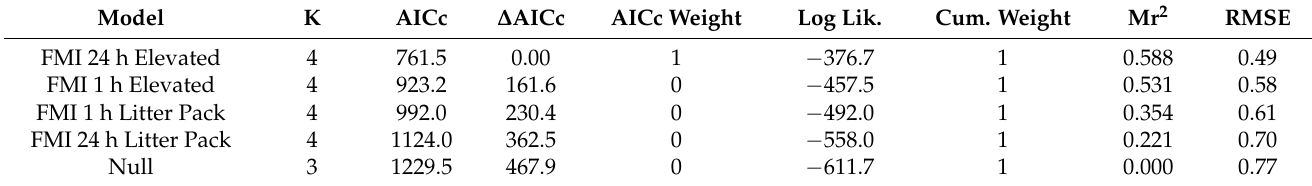
Figure 6. Plots of percentage of litter fine fuel moisture content, percentage of gravimetric fuel moisture stick fuel moisture content, and 24 h Fuel Moisture Index (FMI). ( a ) Percentage of gravimetric fuel moisture stick (c. 10 h fuels) moisture content (% FMC) plotted against percentage of gravimetric litter (c. 1 h fuels) fine fuel moisture content (FFMC %). ( b ) Highest-ranking linear mixed model that relates 24 h 0.75 m elevated FMI against log gravimetric litter fine fuel moisture content (FFMC %). Forest types are indicated by coloured dots, where red = dry forests and green = wet forests. Table 1. Akaike information criterion (AIC) statistics for linear mixed models, with site as a random effect for log fuel moisture content predicted by FMI.